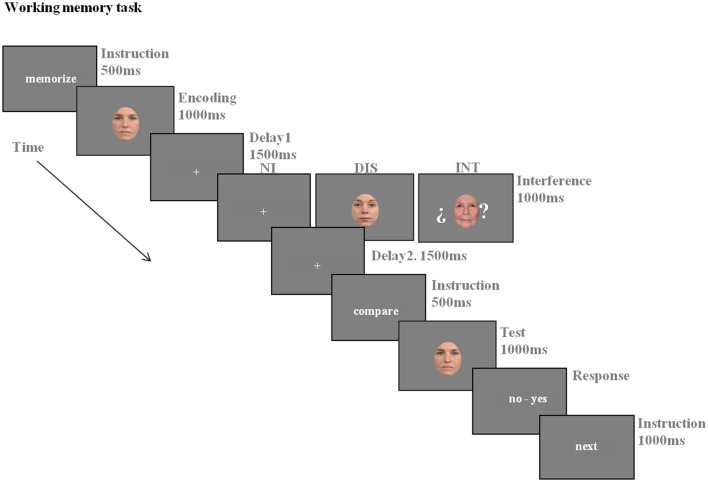
The working memory task consisted of three conditions: Non-Interference (NI), Distraction (DIS), and Interruption (INT). All of the conditions were structured in three main phases: encoding, delay and recognition (See Experimental Paradigm section for details).